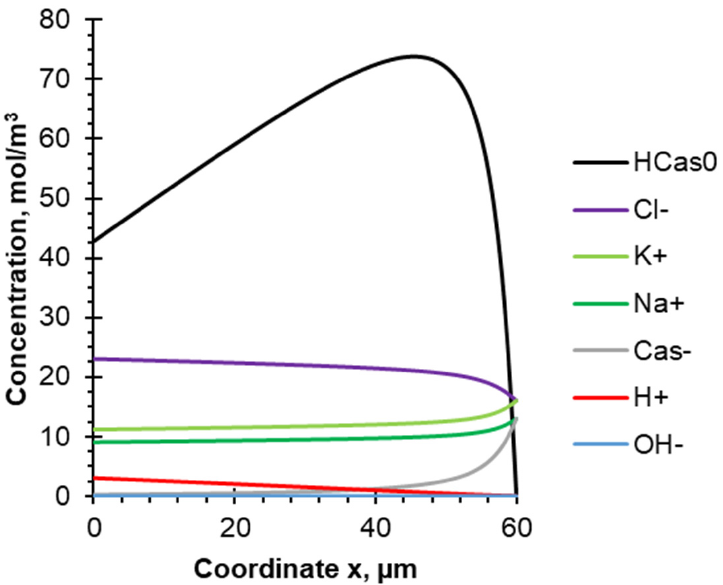
Figure 6. Concentration profiles of the species present in the model solution between the surface of the BPM cation-exchange layer (x = 0) and the outer boundary of the DBL (x = 60 µm). Calculations are made for the CC mode, steady state condition (1800 s after the current was turned on) and flow rate corresponding to Re = 560 and DBL thickness δ = 60 µm.